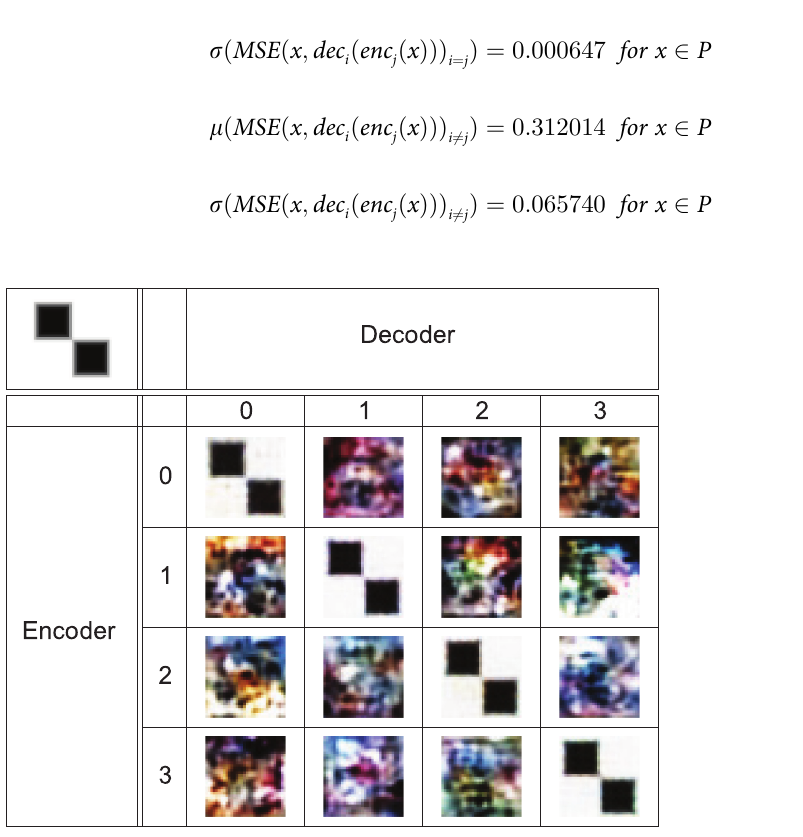
Fig 9. Combinations of (encoder, decoder) pairs from various instances. Results of dec i ( enc j ( x )) where the original image x is shown in upper left corner. The x is properly recreated only if i == j . Use of test pattern shows that dec i ( enc j ( x )) for i 6¼ j has no similarity to x